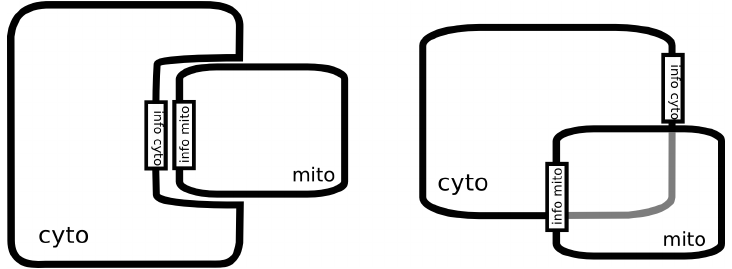
Figure 2.20: Overlapped compartments are permitted, but the overlap does not imply con-